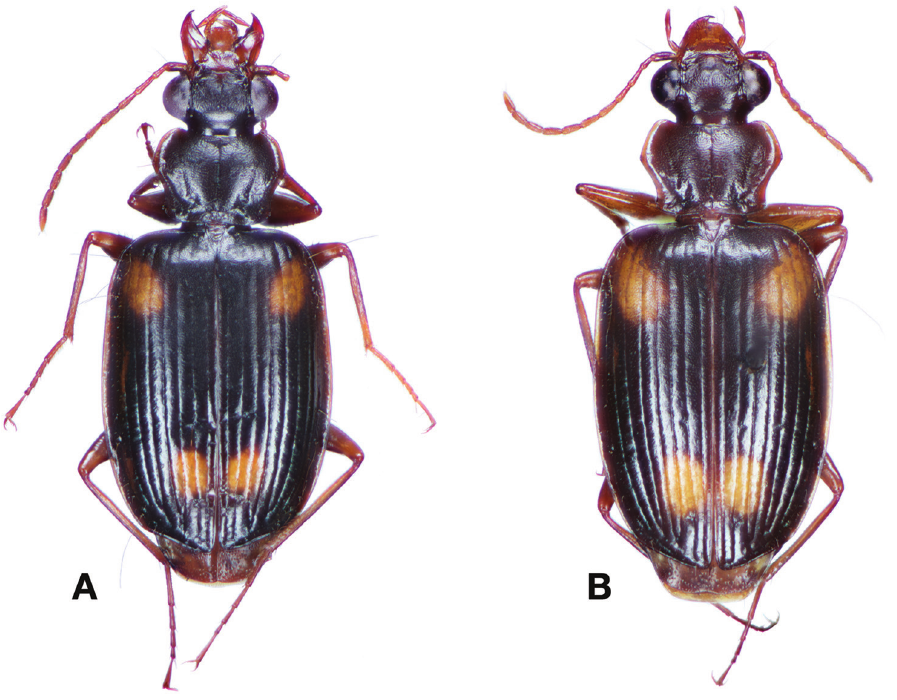
Figure 97. Dorsal habitus and intrapopulation variation of color pattern of Mochtherus obscurabasis sp. n.. A small elytral macula (OBL 8.17 mm) B large elytral macula (OBL 8.67 mm). Color . Fig. 97A, B. Dorsum of head rufo-brunneous to piceous, clypeus rufo- brunneous to brunneo-piceous, lighter than head, labrum brunneous,